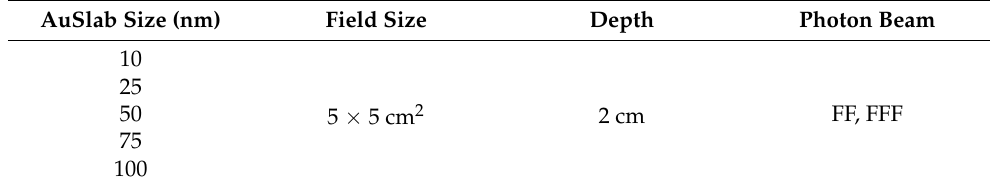
Table 1. Simulation parameters for size effect in dose enhancement.